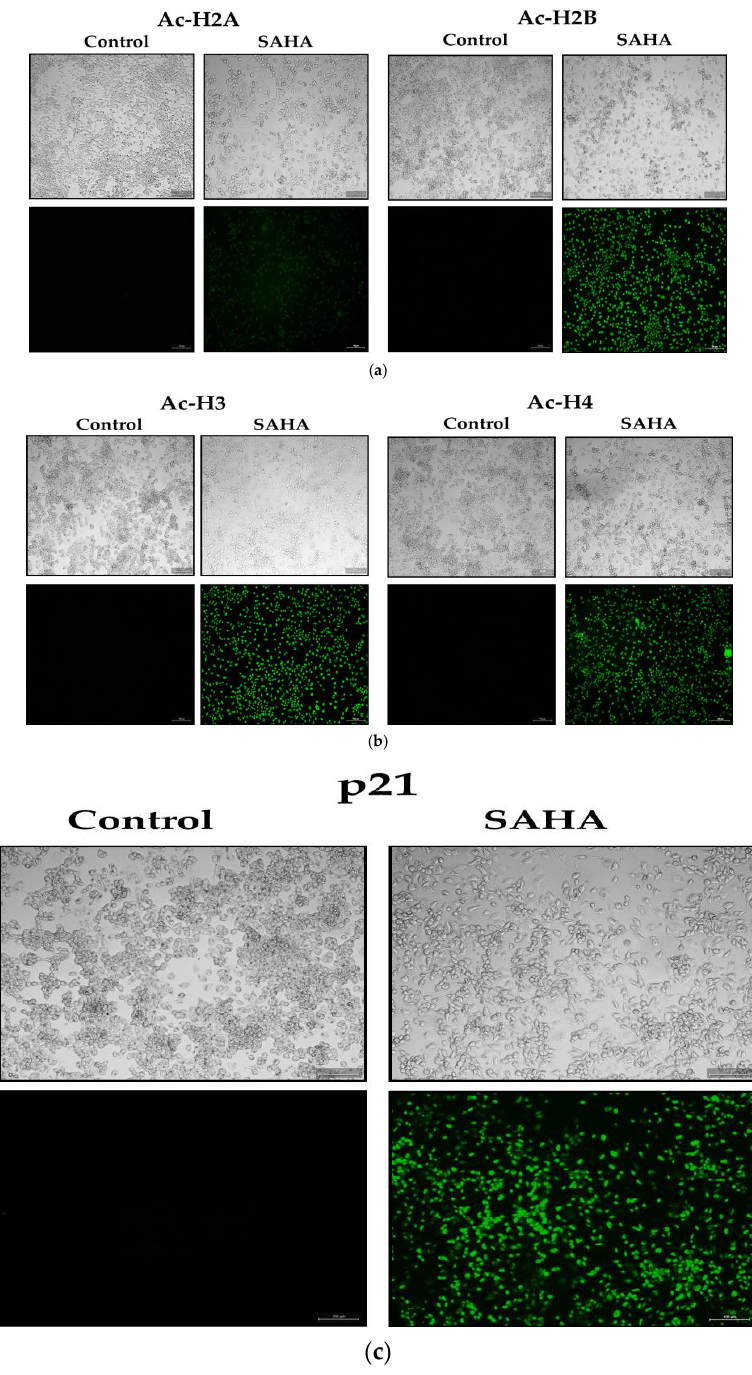
Figure 7. ( a ). A2780 monolayer cells stained for acetylated histones H2A and H2B. The light microscopic images of A2780 cells after SAHA (7.5 µM) treatment in the upper panels. The results of immunocytochemical detection of Ac-H2A and Ac-H2B are shown in the lower panels (green fluorescence) and visualized using Alexa Fluor ® 488. The monolayer cells were observed under Leica (DMI3000 B) microscope using 10× magnification. ( b ). A2780 monolayer cells stained for acetylated histones, including H3 and H4. The light microscopic images of A2780 cells after SAHA (7.5 µM) treatment in the upper panels. The results of immunocytochemical detection of Ac-H3 and Ac-H4 are shown in the lower panels (green fluorescence) and visualized using Alexa Fluor ® 488. ( c ). The A2780 monolayer cells of were stained for p21. The light microscopic images of A2780 cells after SAHA (7.5 µM) treatment in the upper panels. The results of immunocytochemical detection of p21 WAF1/CIP1 levels are shown in the lower panels (green fluorescence) and visualized using Alexa Fluor ® 488.